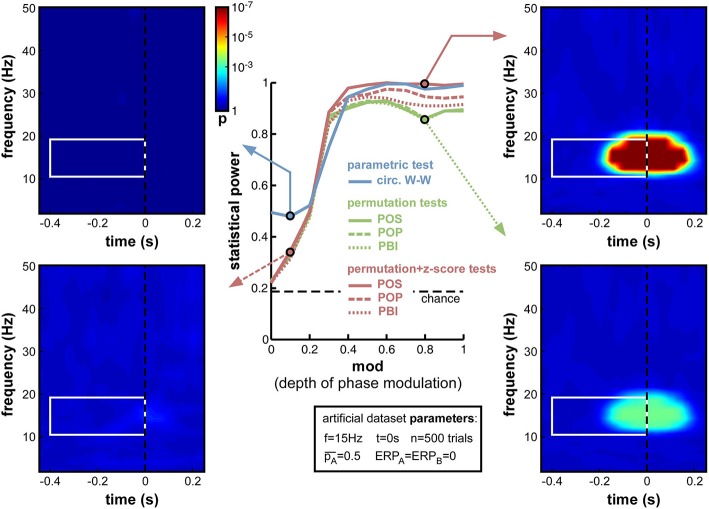
Effect of varying depth of oscillatory phase modulation. The central plot illustrates the changes in statistical power caused by the parameter variations. The line colors correspond to those used in Figures 2, 4. The solid blue line plots the statistical power of the circ. W-W test. Solid, dashed and dotted lines correspond respectively to POS, POP, and PBI, in green for the standard permutation tests, and red for the hybrid permutation + z-score tests. The fixed parameters for these simulations are listed in the box below the main plot. In this and the following figures, four representative time-frequency maps of p-values (obtained by log-averaging the p-value maps from the 100 simulated datasets) are displayed for illustrative purposes. The arrow pointing to each map identifies the measure and the parameter value being illustrated. All maps share the same color scale (see colorbar next to the top-left map). The target time-frequency region is highlighted using a white box. Significant pre-stimulus time-frequency points inside vs. outside this box count as hits and false alarms (respectively) for the calculation of statistical power.